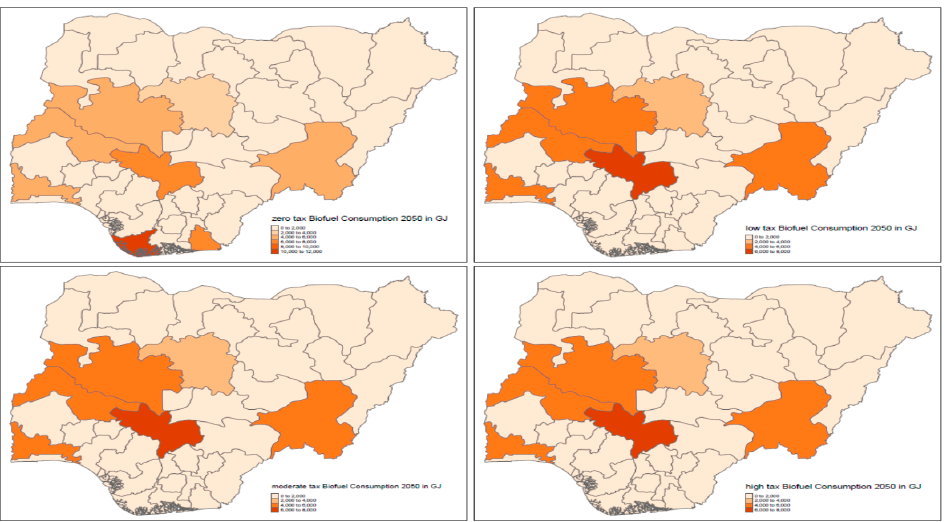
Figure 10. Biofuel consumption by 2050 under subsidy action.